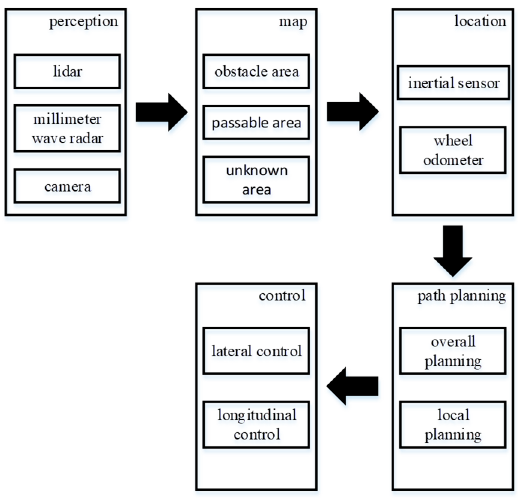
Figure 3. Unmanned vehicle handling operation block diagram.